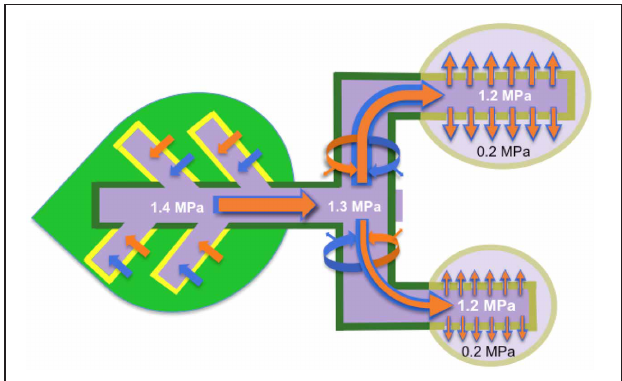
FIGURE 1 | High-pressure manifold model that describes phloem transport from source to sink and partitioning of resources (water and dissolved solutes) between sinks. Sucrose is loaded (brown arrows) into the collection phloem (minor veins; yellow borders) of source leaves to high